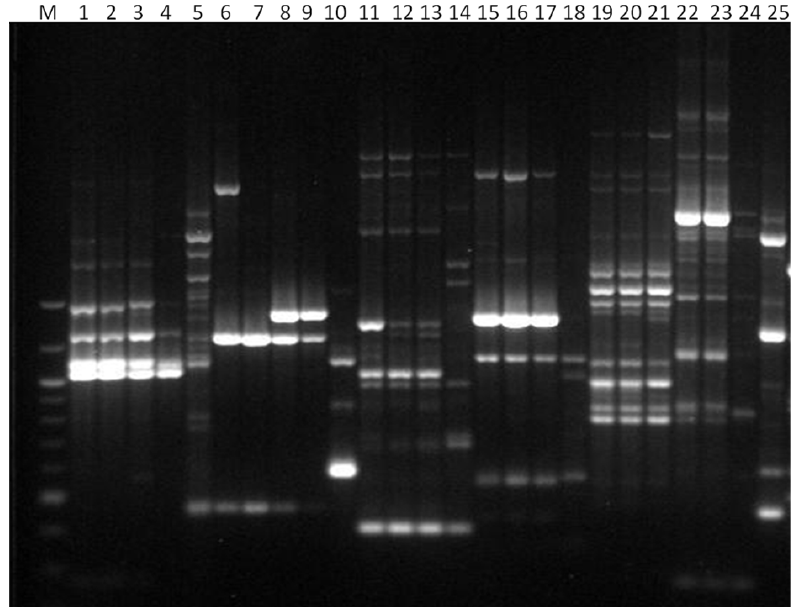
Figure 5. RAPD banding profiles generated with primers R5 (lanes 1–5, 11–14, 19–21, 25–27, 31–33, and 37–38) and RF2 (lanes 6–10,15–18, 22–24, 28–30, 34–36, and 39–40). M: 100 bp DNA marker; 1, 6: S. bacillaris Sb N11; 2, 7: S. bacillaris Sb P51; 3, 8: S. bacillaris Y-14; 4, 9: S. bacillaris Sb P13; 5, 10: S. bacillaris CECT 31235; 11, 15: I. orientalis Io P8; 12, 16: I. orientalis Io P14; 13, 17: I. orientalis Io N5; 14, 18: I. orientalis Y-6; 19, 22: T. delbrueckii Td N6; 20, 23: T. delbrueckii Td N13; 21, 24: T. delbrueckii TO2.